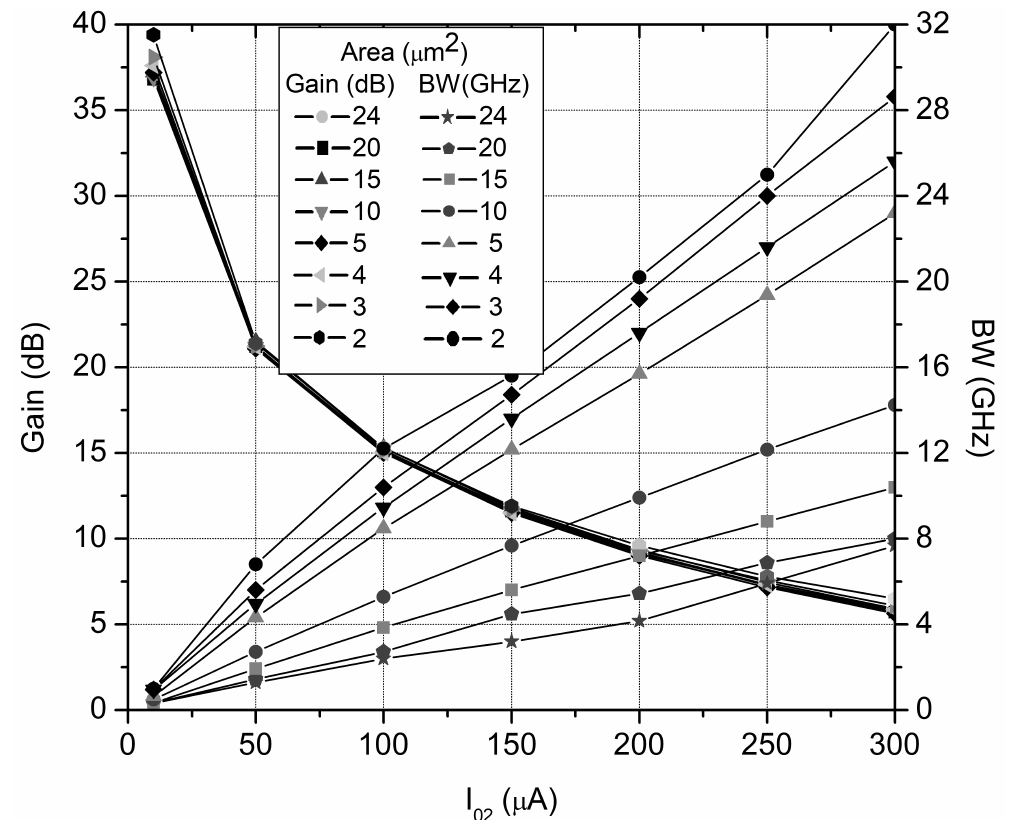
Figure 5. Simulated gain and bandwidth results of the RF-VGA at V DC = ± 1.5